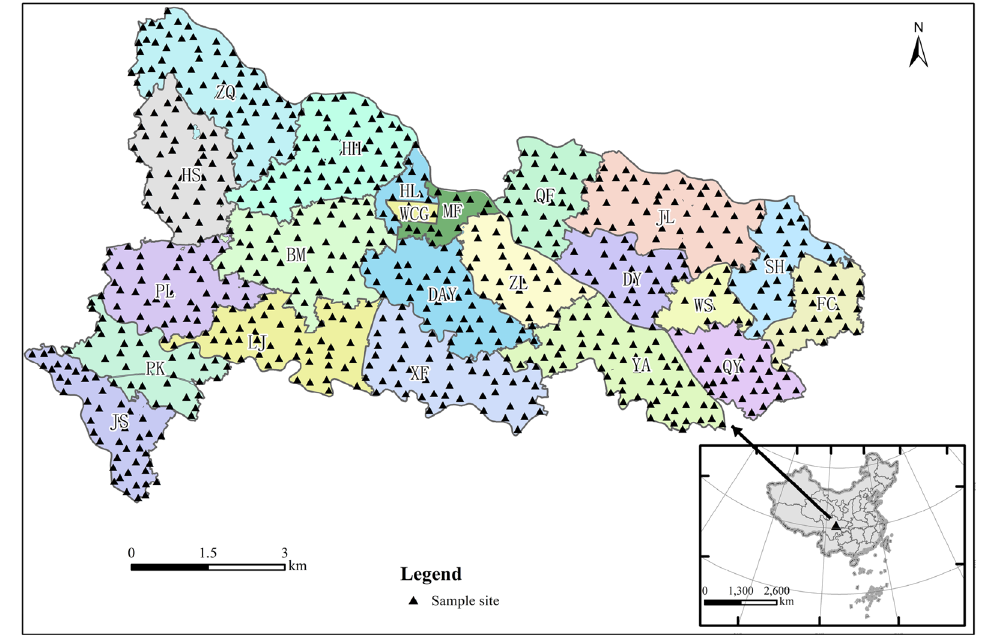
Figure 1. Locations of sub regions of study area and sampling sites (map were generated with software ArcMap10.8 http:// www. esri.